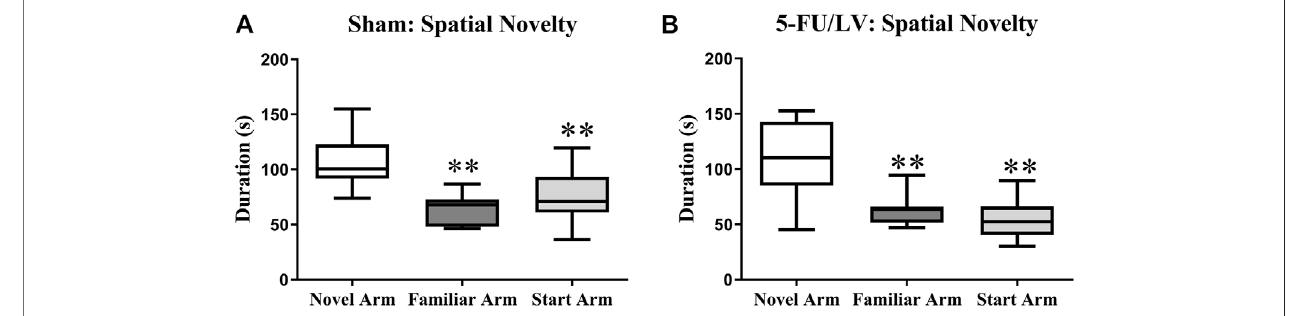
FIGURE 3 | Learning curve data for the MWM task. (A,B) 5-Fu/LV treated mice had a signi fi cantly higher average velocity on day 4 only compared to sham mice. Average ± SEM ( n (cid:1) 15 per treatment Group) * p < 0.05, ** p < 0.01.